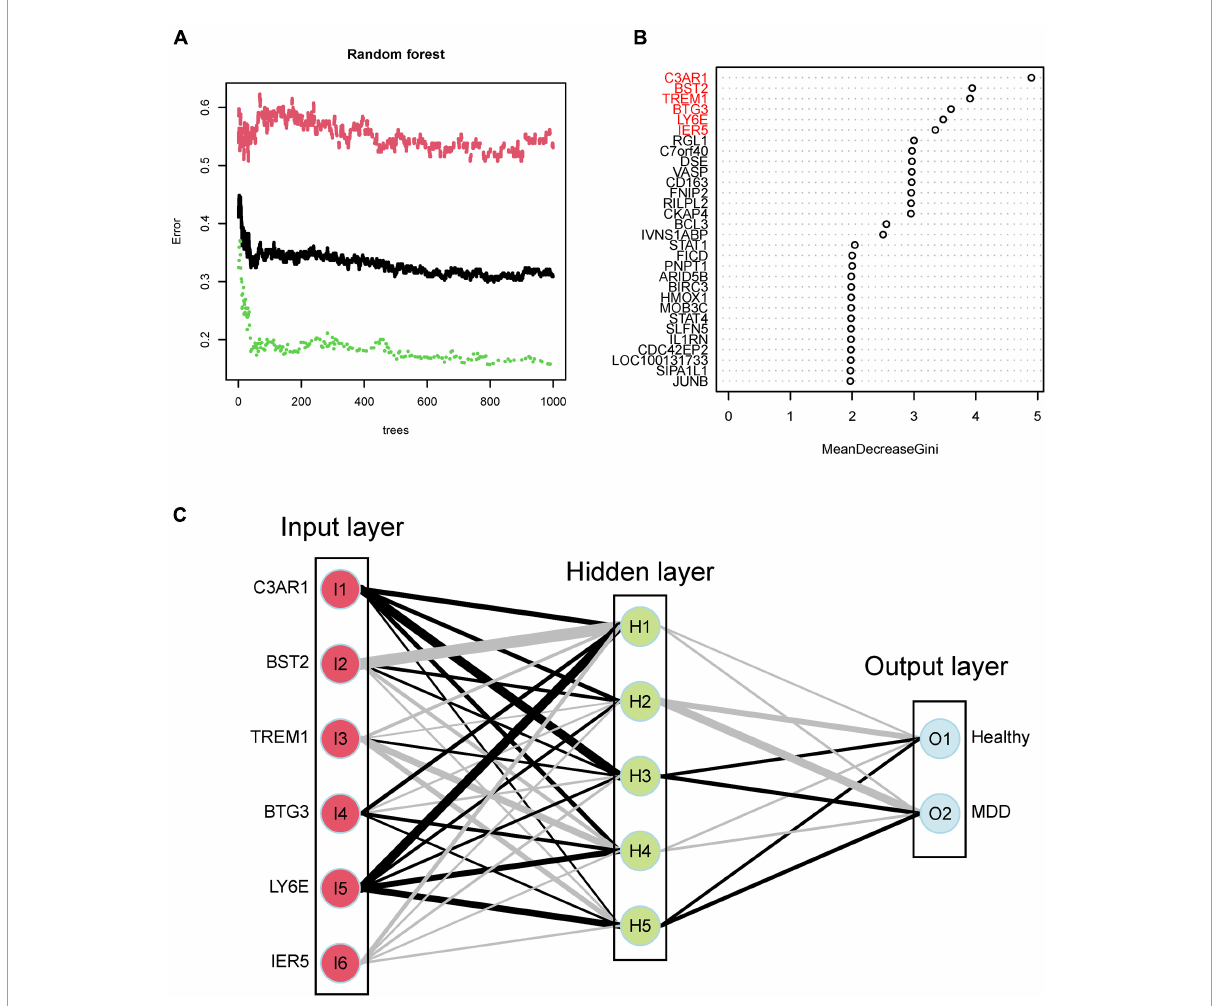
FIGURE4 (A) Random forest tree. (B) MeanDecreaseGini. (C) Artificial Neural Network model. Healthy stands for healthy group, and MDD stands for MDD